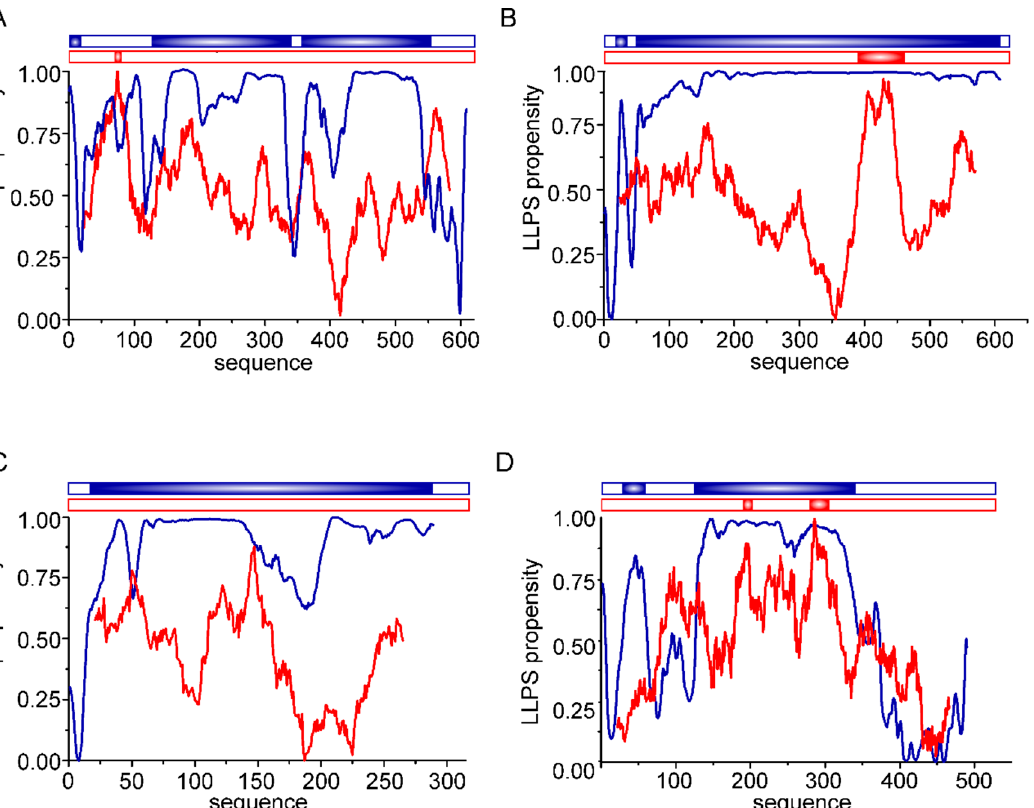
Figure 5. In silico analysis of otolithic proteins. The graph demonstrates the normalized results of in silico analysis of representative otolithic proteins: ( A ) OMM-64, ( B ) Stm ( C ), Stm-l, and ( D ) otolin-1 performed using FuzDrop (blue) and PScore (red). The protein regions that obtained positive scores are indicated as a scheme at the top of each panel. [Accessed on 12 May 2022].